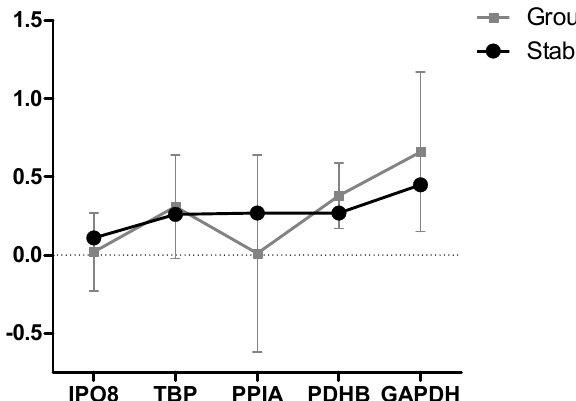
Figure 1. Stability of mRNA expression in fibroblast cell lines from cluster headache (CH) cases and controls. The stability of mRNA expression of five reference genes was assessed in primary fibroblast cell lines from 8 healthy control subjects and 12 CH patients. Comparative analysis to determine the gene with the most stable expression was performed using the software Normfinder [53]. Gene names are listed on the x -axis. IPO8 was the most stable reference gene in these conditions, presenting both high stability (stability value close to zero), and a small difference in mRNA expression (group difference close to zero), with low standard deviation (error bars) between the two groups.